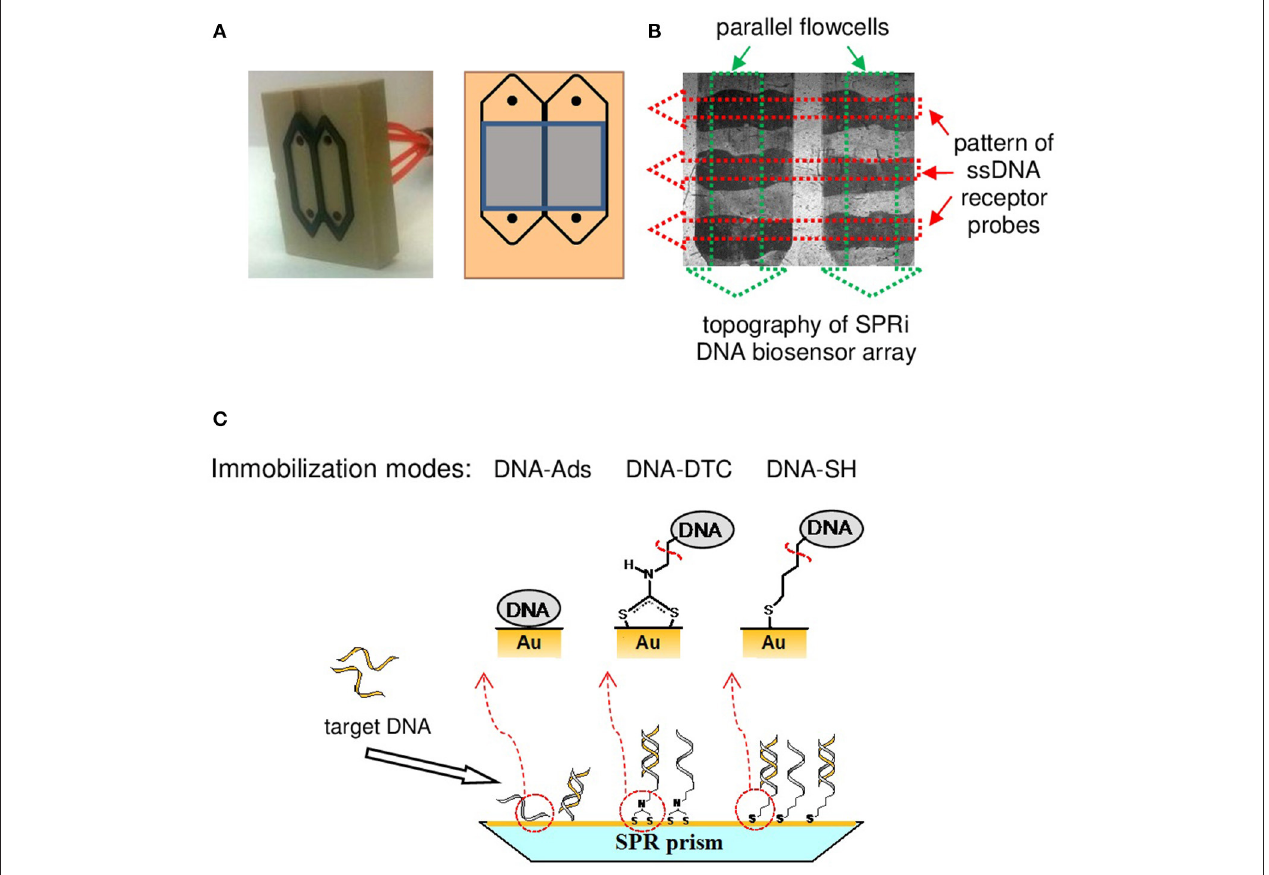
FIGURE 1 | Schematic illustration of SPRi instrumentation and methodology utilized in this work. (A) Image of two-channel, homemade SPRi microfluidic cell (left). Scheme of cell design with indicated detection area of SPRi optical system (right). (B) Flow cell image captured by CCD camera with the schematic of orthogonal pattern of bioreceptor probes (red arrows) and microfluidic cells (green arrows). (C) Schematic representation of the DNA-immobilization strategies examined in the framework of presented studies (magnified side-view of SPRi biochip TM